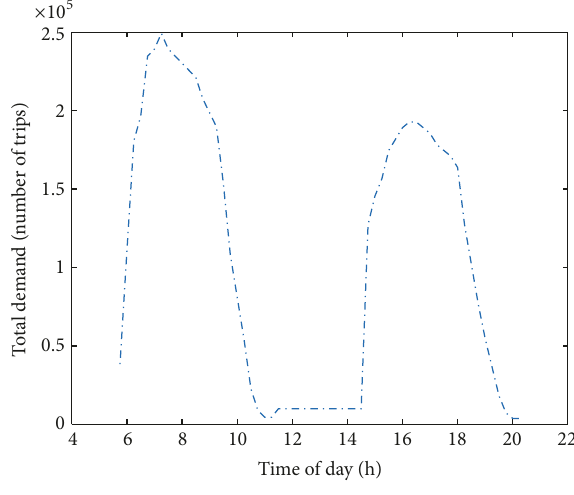
Figure 4: Total demand over the